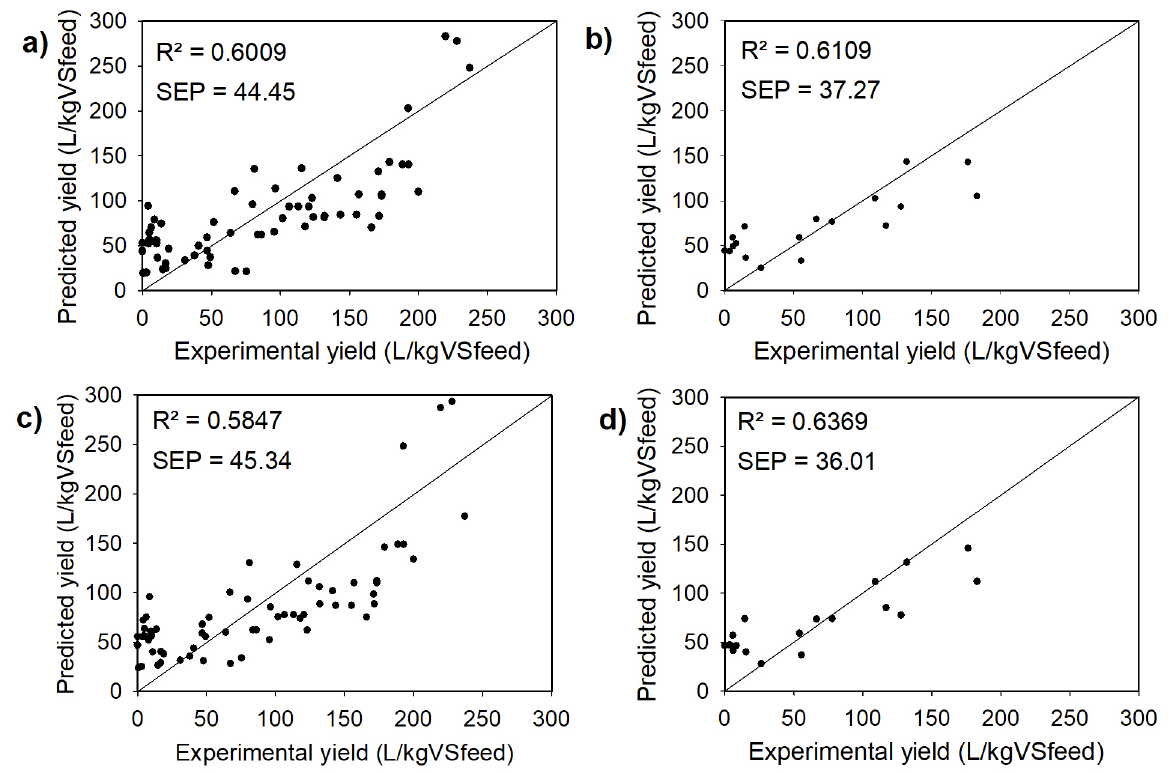
Figure 2 - Comparison between experimental and predicted yield for ( a ) regression and ( b ) validation of the simple linear model with the highest regression R², and for ( c ) regression and ( d ) validation for the model with the highest validation R² . SEP : Standard error of